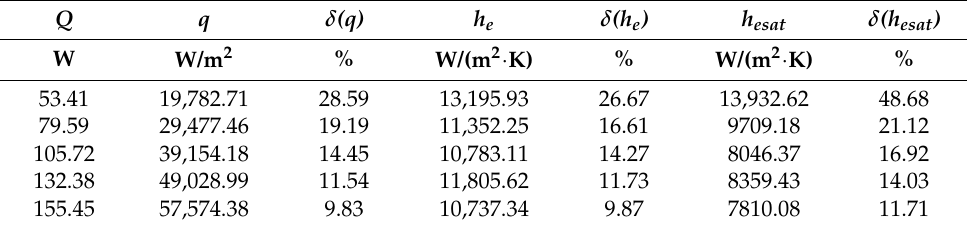
Table 9. Uncertainty values of the computed heat transfer coefficients for LHPs with ceramic